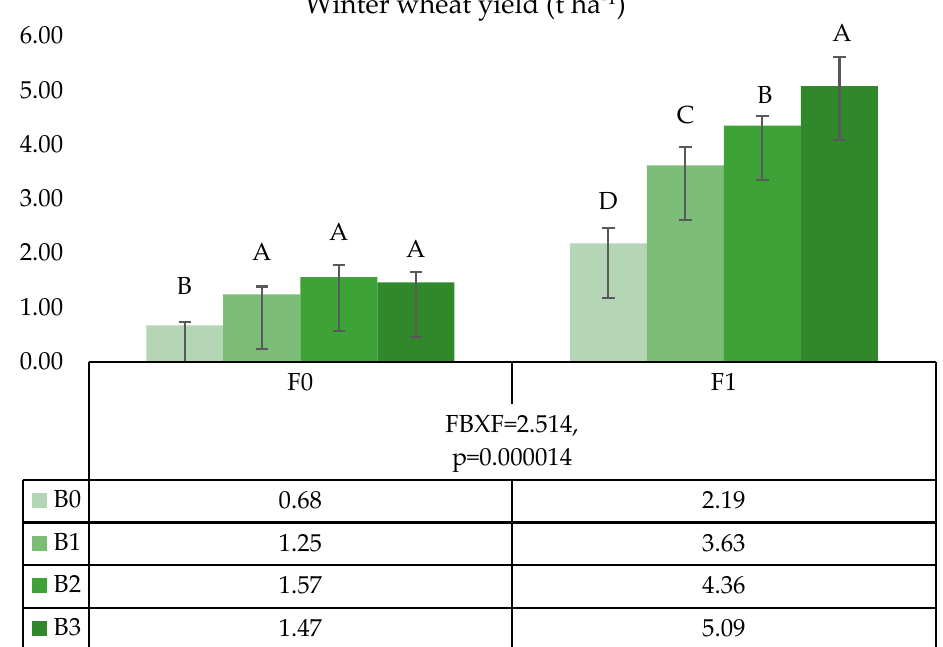
Figure 7. The influence of biochar (B0-0 t ha − 1 , B1-5 t ha − 1 , B2-10 t ha − 1 , B3-15 t ha − 1 ) and fertilization (F0—without fertilization, F1—optimal fertilization) interactions on winter wheat yield. FBXF—F-test for biochar and fertilization interaction, p–p value. Columns marked with different capital letters are statistically different using the protected least significant difference (LSD) test at P < 0.05.